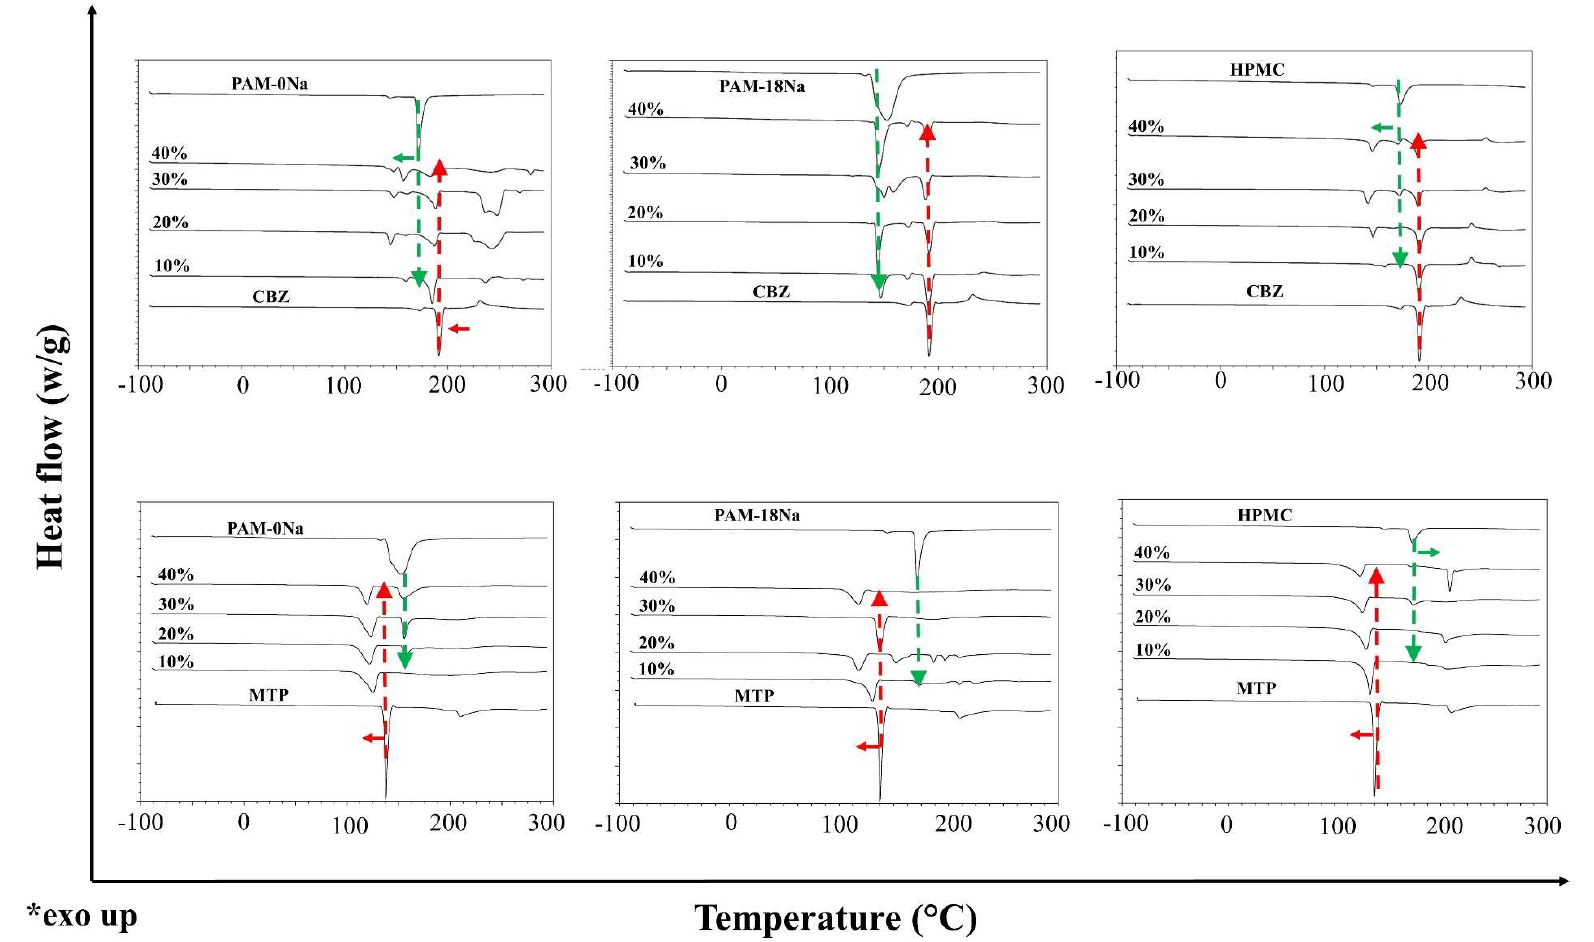
Figure 2. DSC thermogram of mixtures of carbamazepine (upper CBZ) and metoprolol (lower MTP) with the PAM-18Na; PAM-0Na; HPMC polymers at 10%, 20%, 30% and 40% HPMC, hydroxypropyl-methyl cellulose.